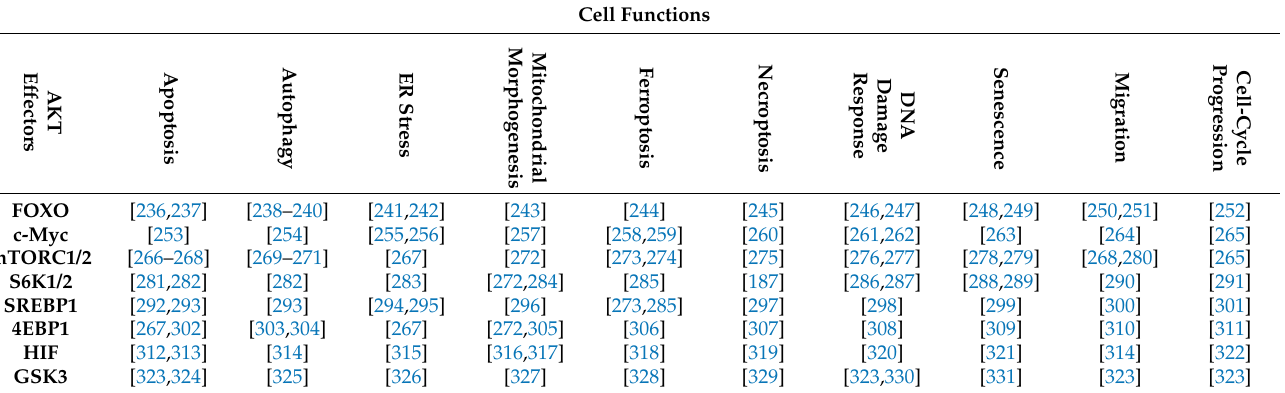
Table 4. AKT effectors regulate cell